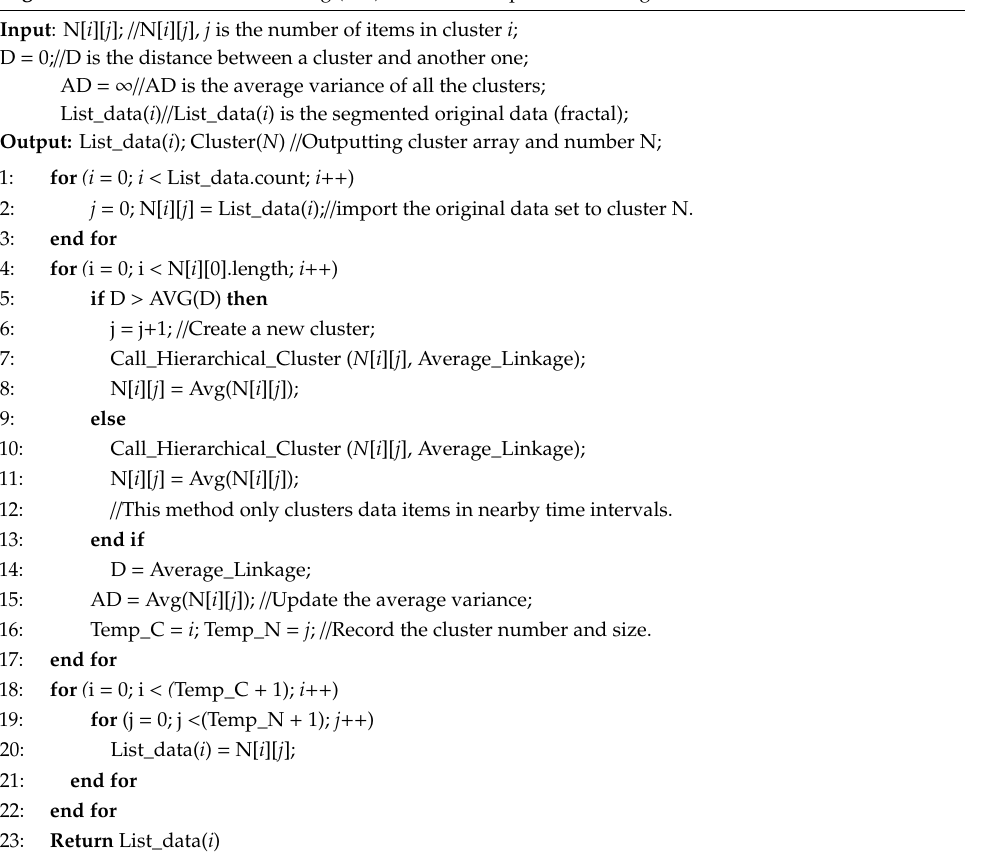
Algorithm 2. Hierarchical Clustering (HC)-Based Data Optimization